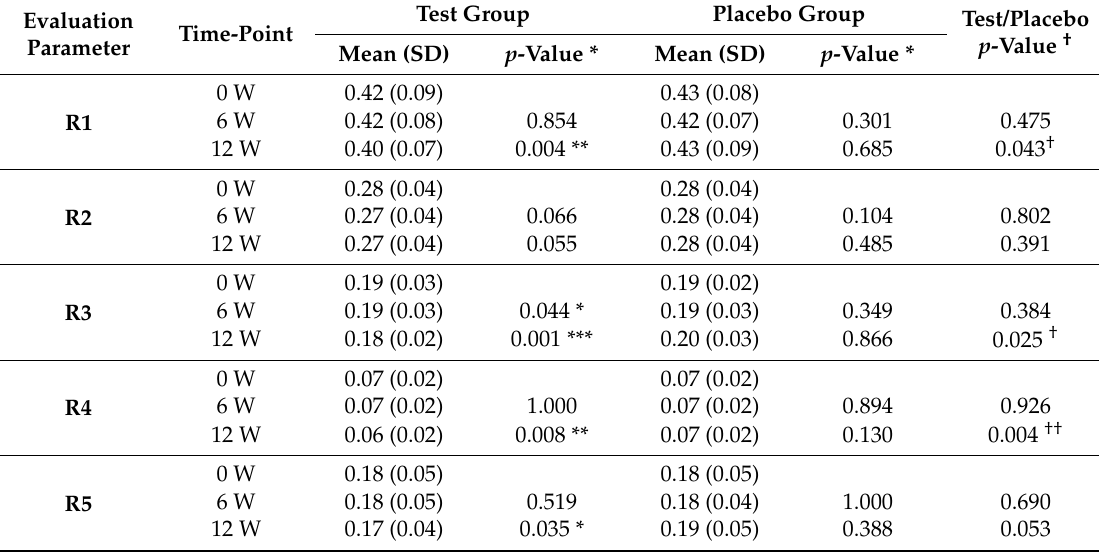
Table 6. Skin-wrinkling parameters measured by Skin Visiometer